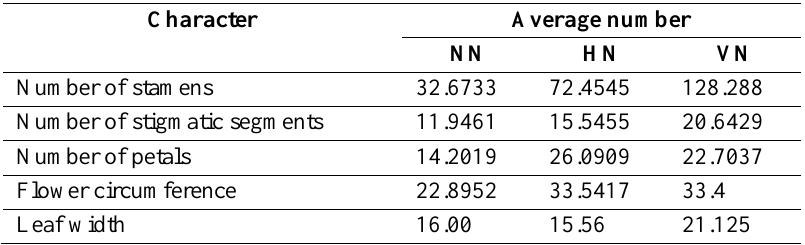
Table 3: Average numbers of the highly contributed characters for the identification of the putative hybrids (NN: N. nouchali ; HN: putative hybrid; and VN: violet flowered Nymphaea